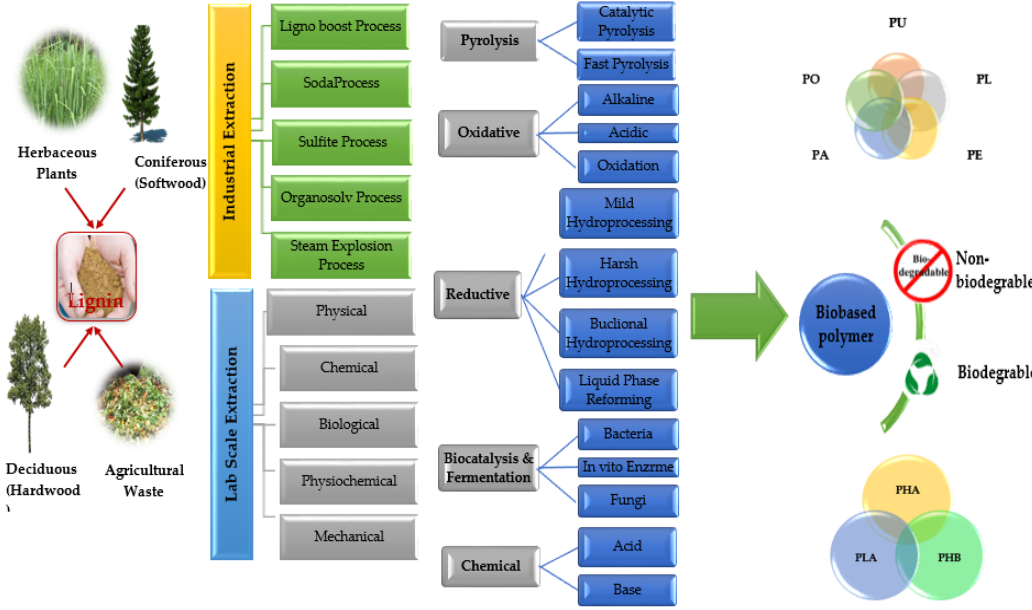
Figure 15. Schematic of overall lignin valorization process for biopolymer production (adapted from [100]).